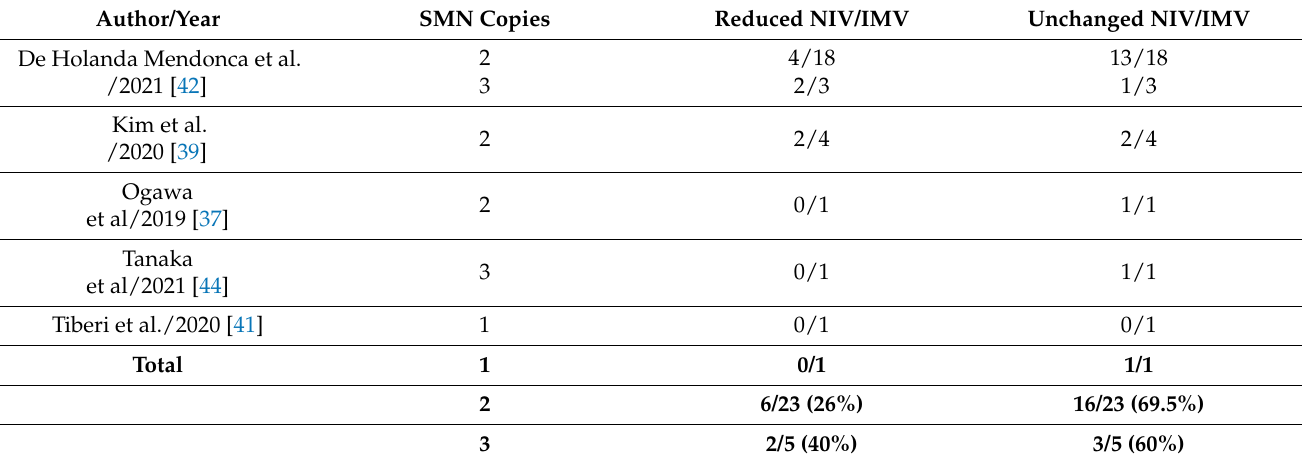
Table 4. Number of SMN copies and post-treatment effect on the needs for respiratory